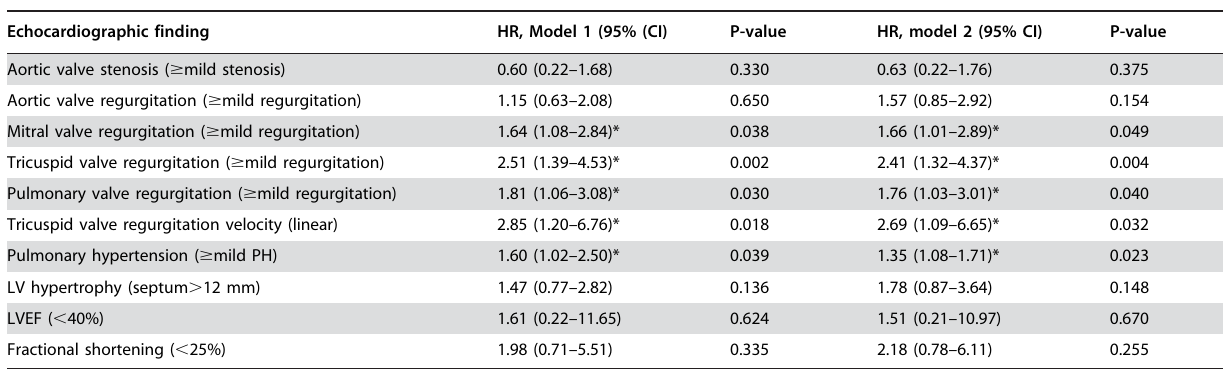
Table 3. Hazard Ratio of a Fall according to Echocardiographic Abnormalities (N=215). .. ... .... ... ... .... ... ... .... ... ... .... ... ... .... ... ... .... ... ... .... ... ... .... ... ... .... ... ... .... ... ... .... ... ... .... ... ... .... ... ... .... ... ... . Echocardiographic